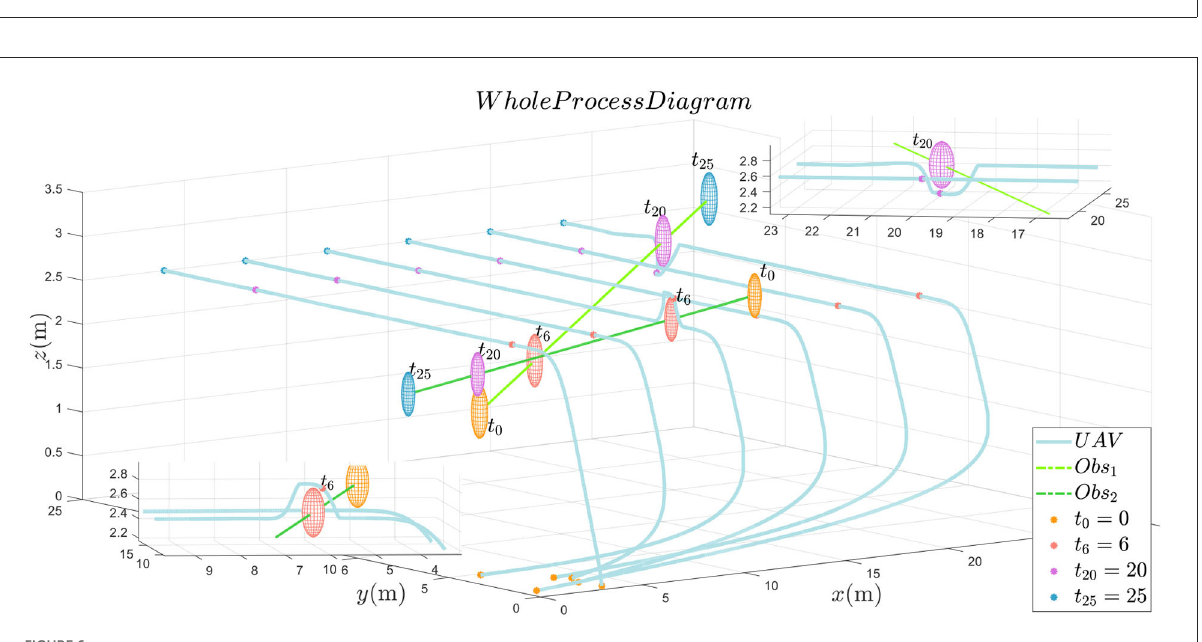
FIGURE6 The whole process